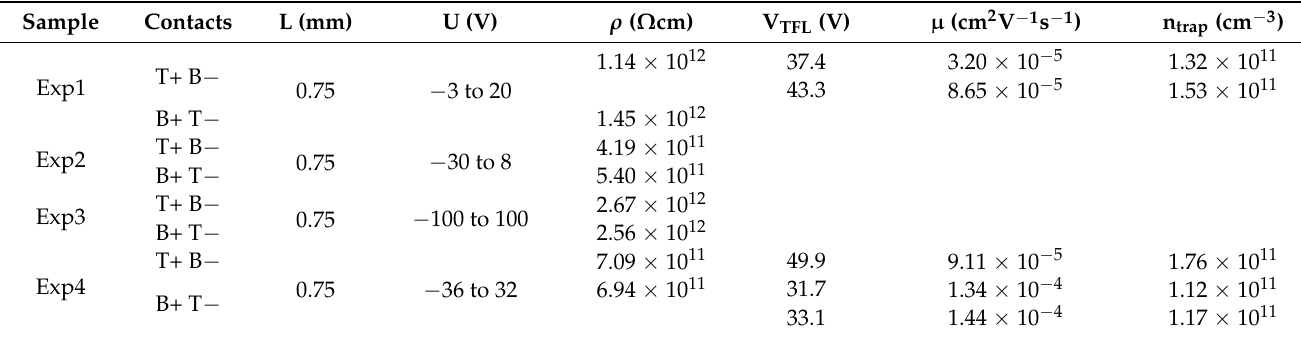
Table 1. Key electrical parameters derived from the IV curves for the (BA) 2 CsAgBiBr 7 sample using Ag glue electrodes.